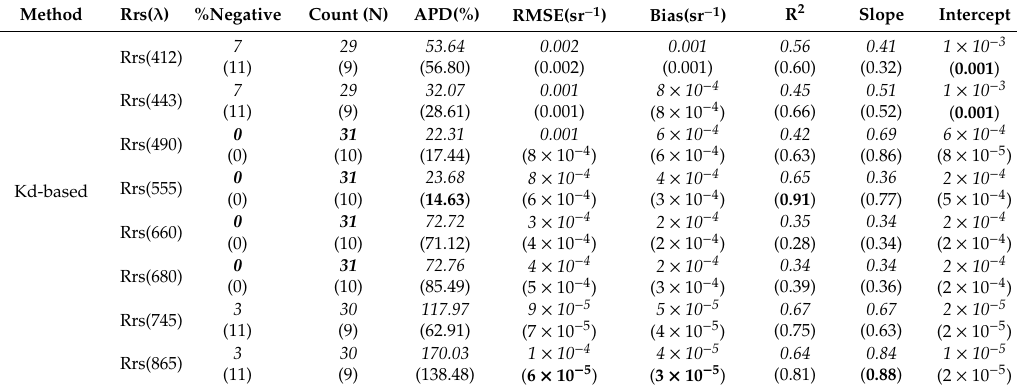
Table 3. Statistical results for GOCI-retrieved Rrs values obtained using the Kd-based algorithm and the in situ Rrs comparison at 02:16, 03:16, and 04:16 UTC for ± 3 h (values in parentheses indicate results for ± 1 h). The presentation style is the same as described in Table 1.